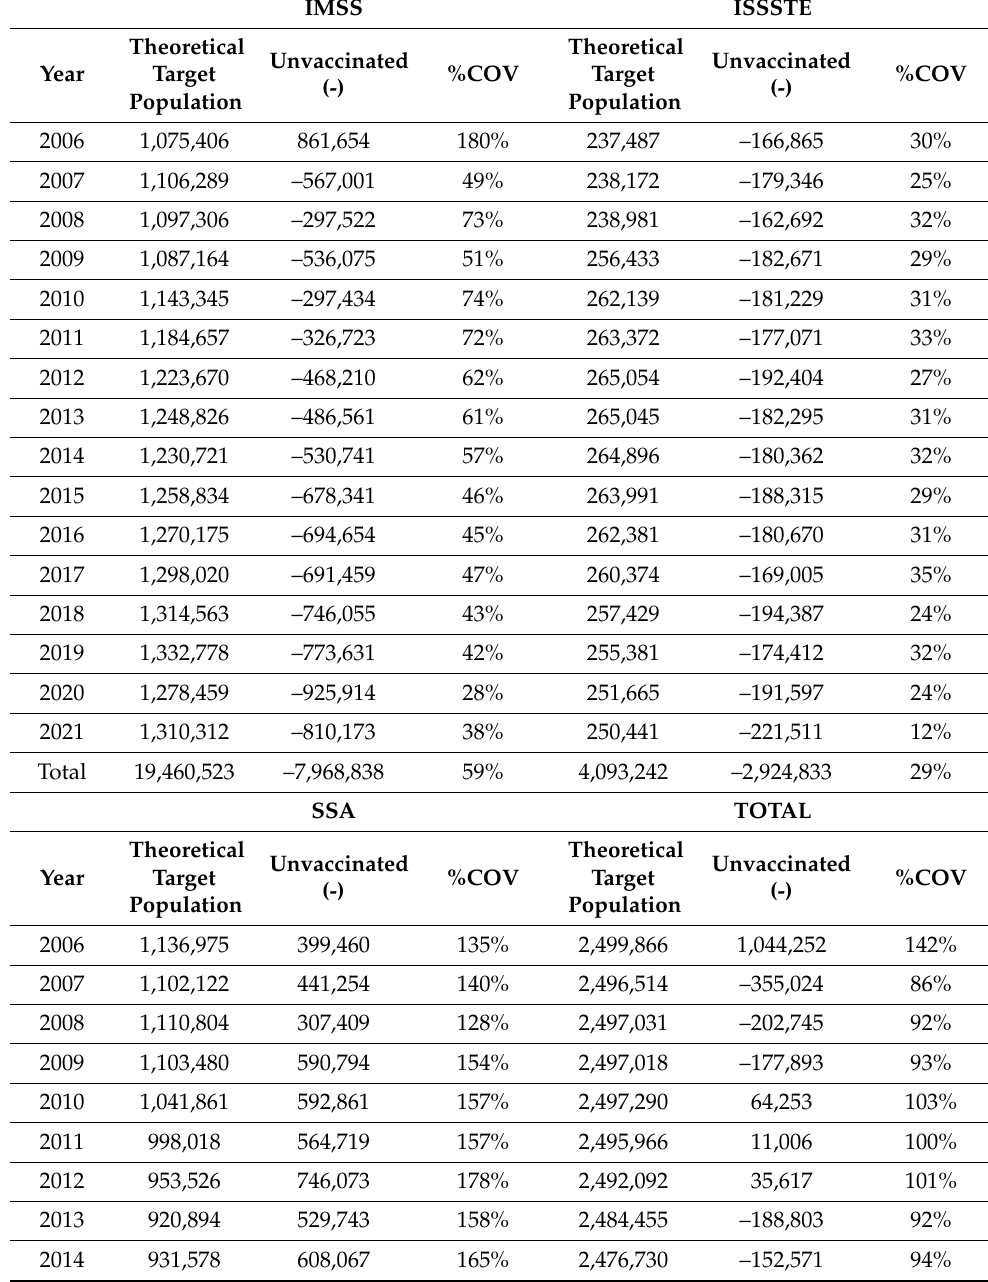
Table 4. BCG Theoretical target population, unvaccinated individuals and